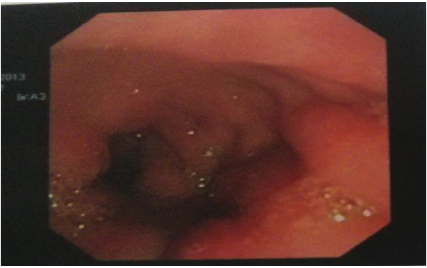
Figure 5: Duodenum at stent removal after removal of